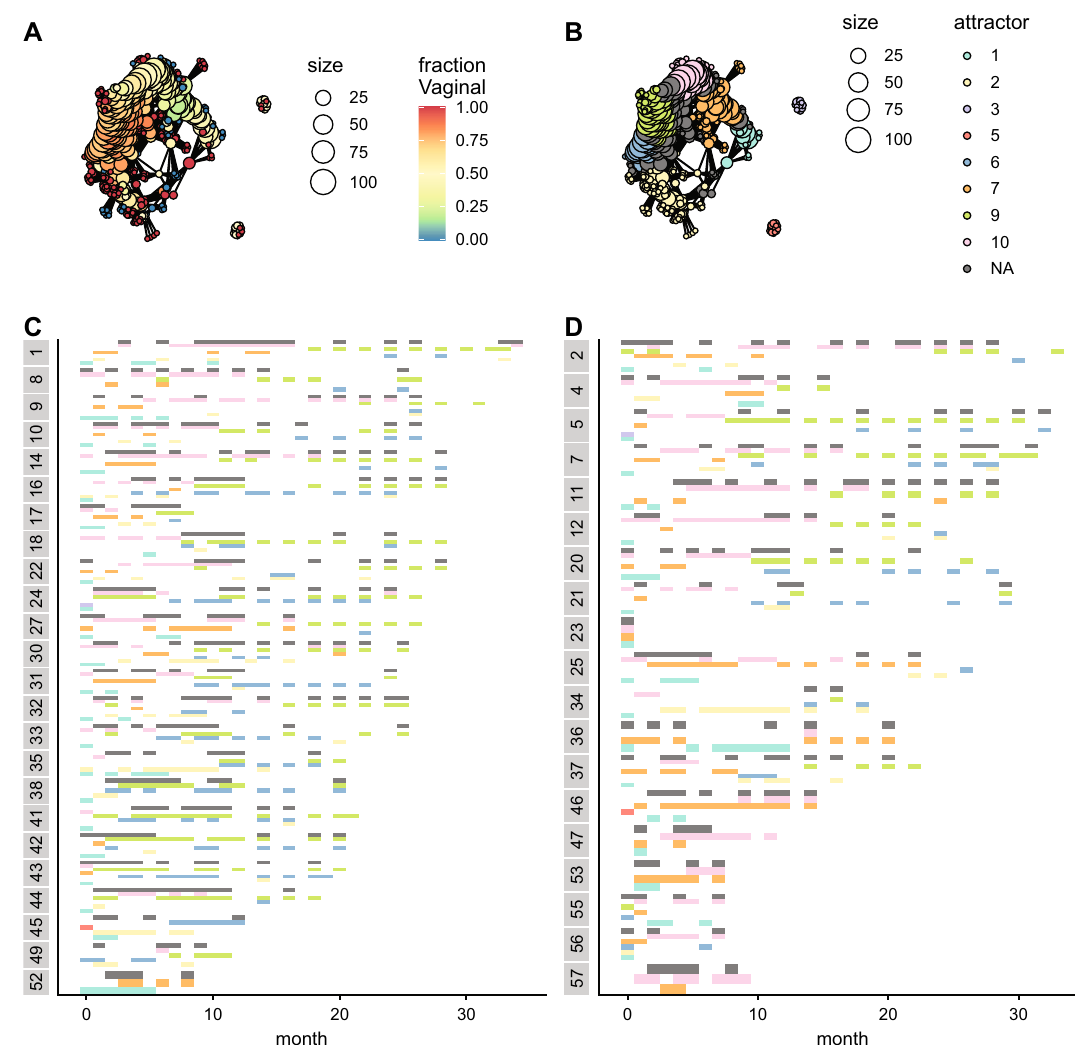
Figure 3. Ecological succession of human microbiota communities in a functional phase space, using the KEGG annotation. ( A ) Mapper representation of the samples. The colour represents the fraction of samples from individuals born vaginally, instead of caesarean section. ( B ) Partition of the mapper network into metastable states. Each colour corresponds to an attractor. ( C , D ) Attractor occupied per individual and month. Each row corresponds to a single individual. The colours correspond to the attractors in ( B ). ( C ) Individuals born vaginally. ( D ) Individuals born via caesarean